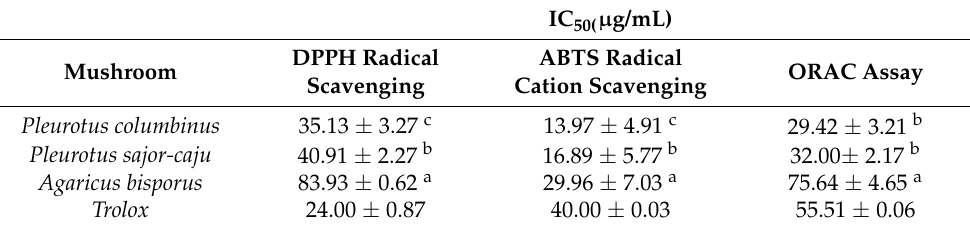
Table 6. IC 50 values of Pleurotus columbinus , Pleurotus sajor-caju , and Agaricus bisporus in the DPPH, ABTS radical scavenging, and ORAC